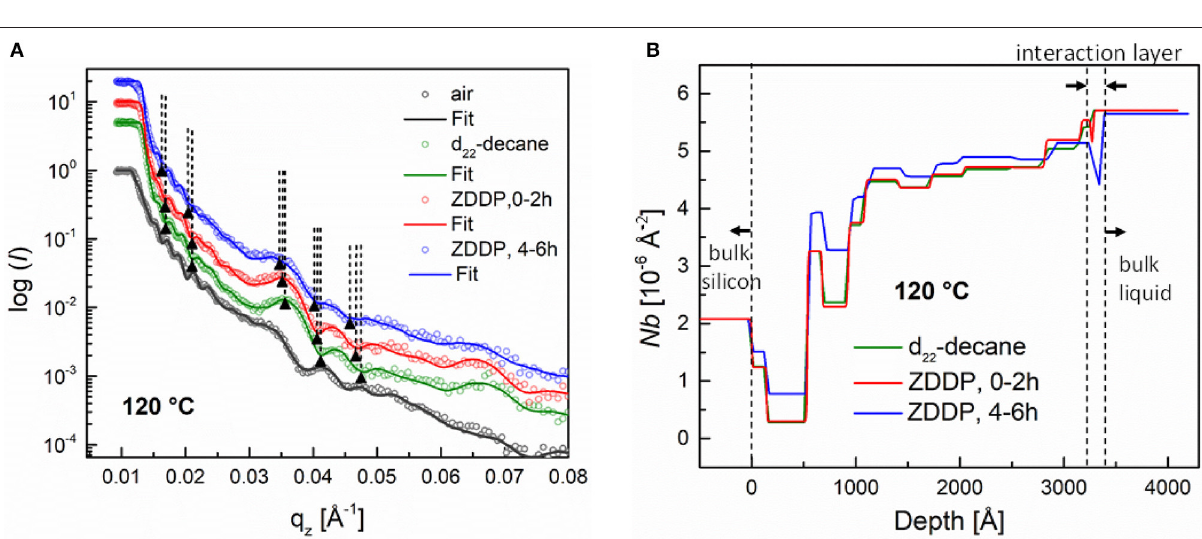
FIGURE 8 | (A) Neutron reflectivity profiles (dots) and best fits (continuous lines) for an a-C:H coating measured in air, in deuterated decane, and finally in the presence of a 1 wt.% ZDDP solution for various exposure times at 25 ◦ C, (B) SLD profiles extracted from the fitted curve. The SLD profile for an a-C:H coating in air is omitted for the sake of clarity.